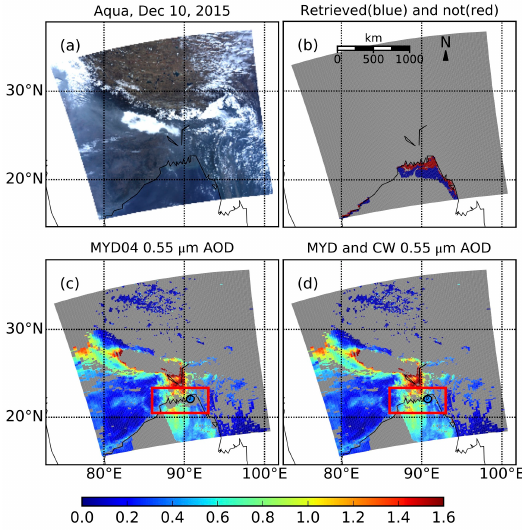
Figure 5. ( a ) Aqua MODIS true color image on 10 December 2015. ( b ) Blue and red represents coastal water where MYD AOD retrievals are available (blue) and unavailable (red), respectively in clear sky condition. ( c ) MYD04 0.55 μ m DT/DB merged AOD retrievals. ( d ) is similar to ( c ), but the coastal water gaps where MYD04 AOD retrievals are not available in clear sky condition (red box) are filled by AOD retrievals from CW algorithm. AERONET AOD measurement overlaps on ( c ) and ( d ).